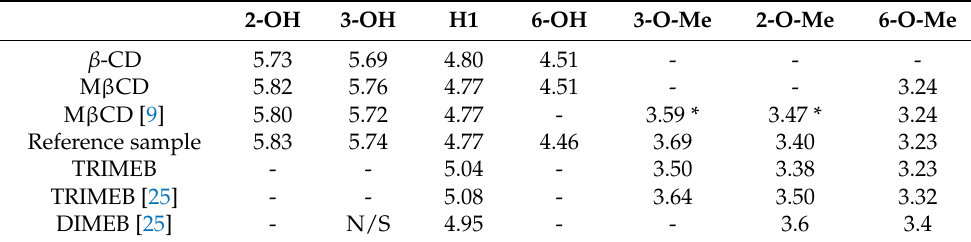
Table 1. 1 H-NMR chemical shifts for β -CD and methylated β -CD in DMSO-d6.